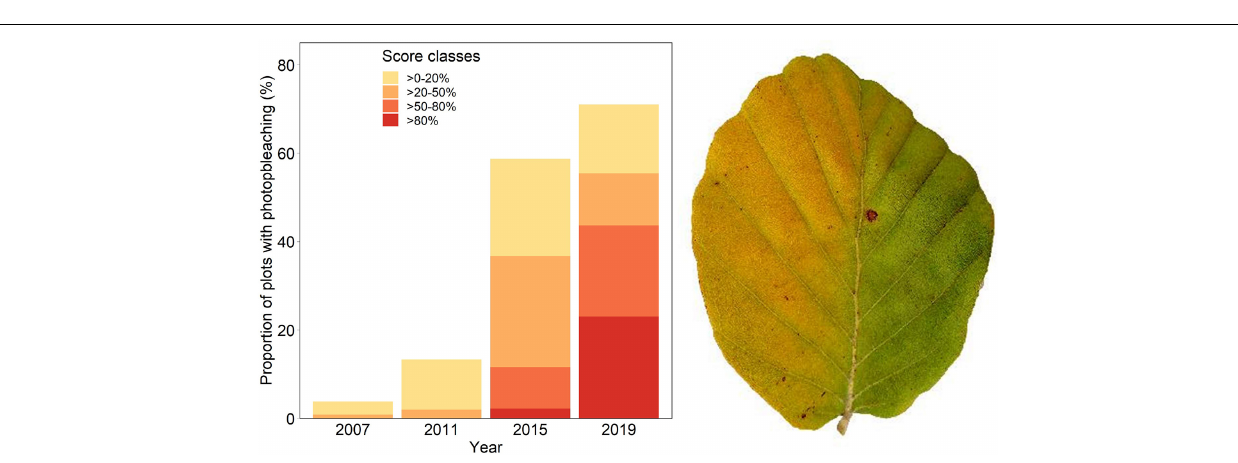
FIGURE 7 | Frequency of occurrence of photobleaching (left) and leaf with sign of strong photobleaching (right) : the right half of the leaf was covered by another leaf.